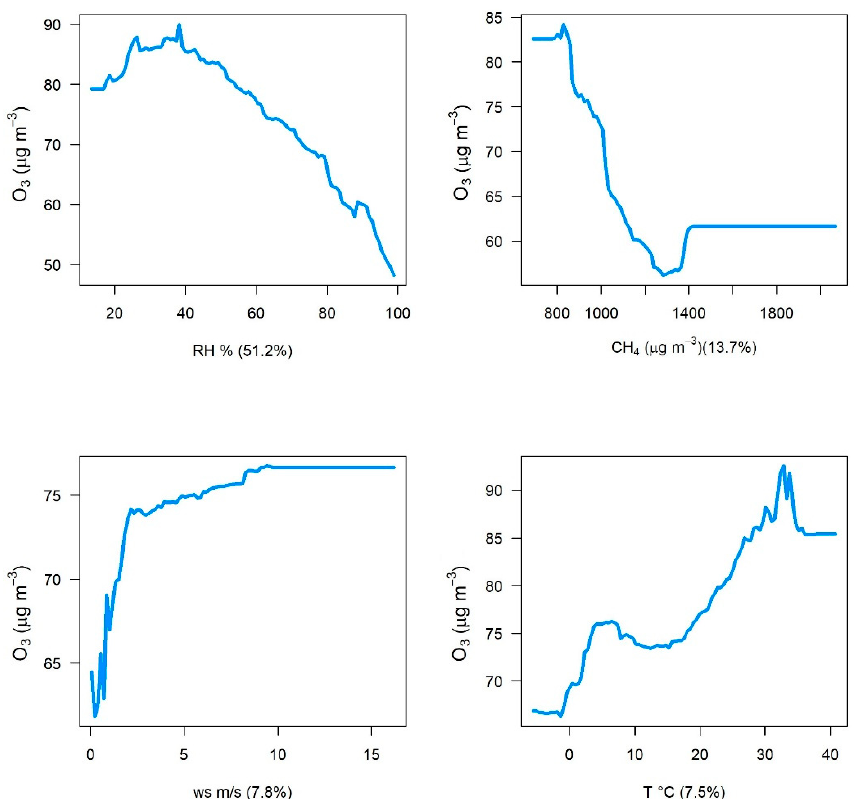
Figure 4. Partial dependence plots showing the variation in hourly O 3 concentrations as a function of the top four predictors used in the boosted regression tree (BRT) model.